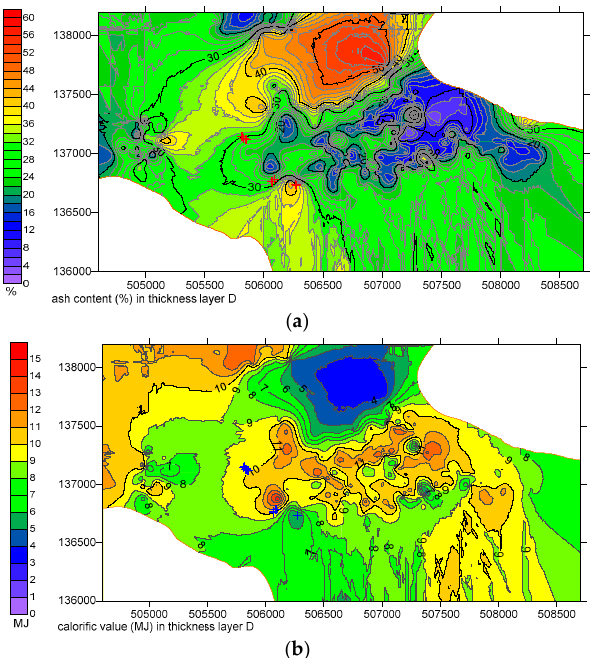
Figure 12. ( a ) Ash content of coal and locations of coal bursts source in thickness layer D; and ( b ) calorific value of coal and coal burst source locations in thickness layer D. Thickness layer E: No coal burst source was recorded in the lower part of the coal seam in thickness layer E.